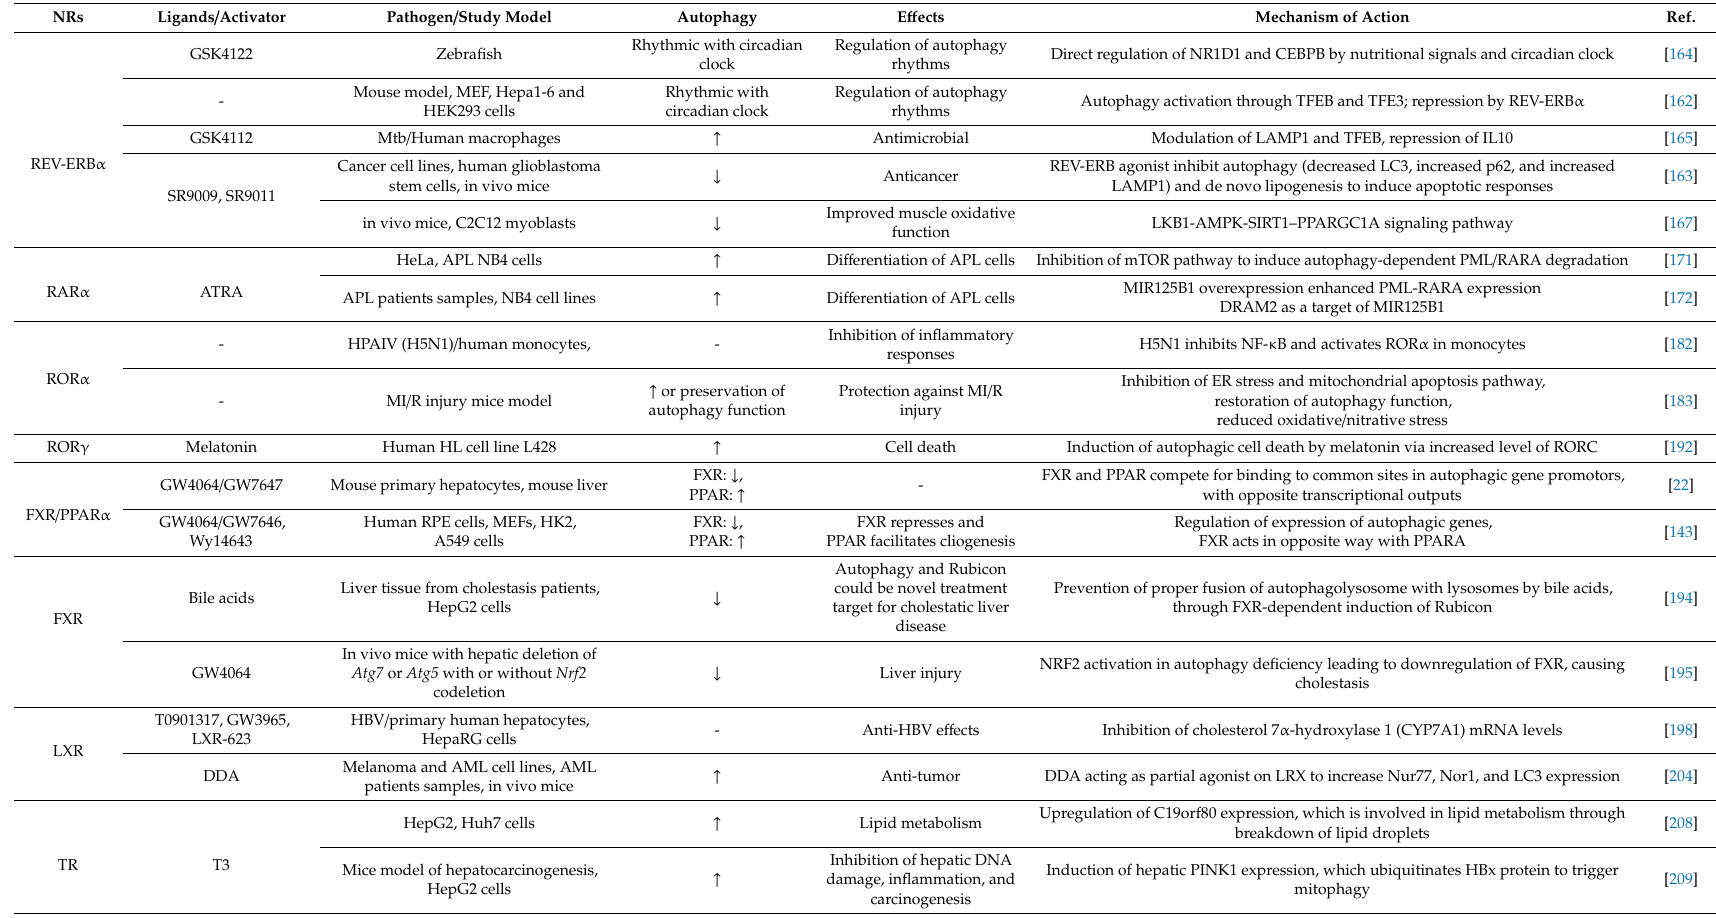
Table 4. Several nuclear receptors (NRs) with potential functions in linking autophagy and host